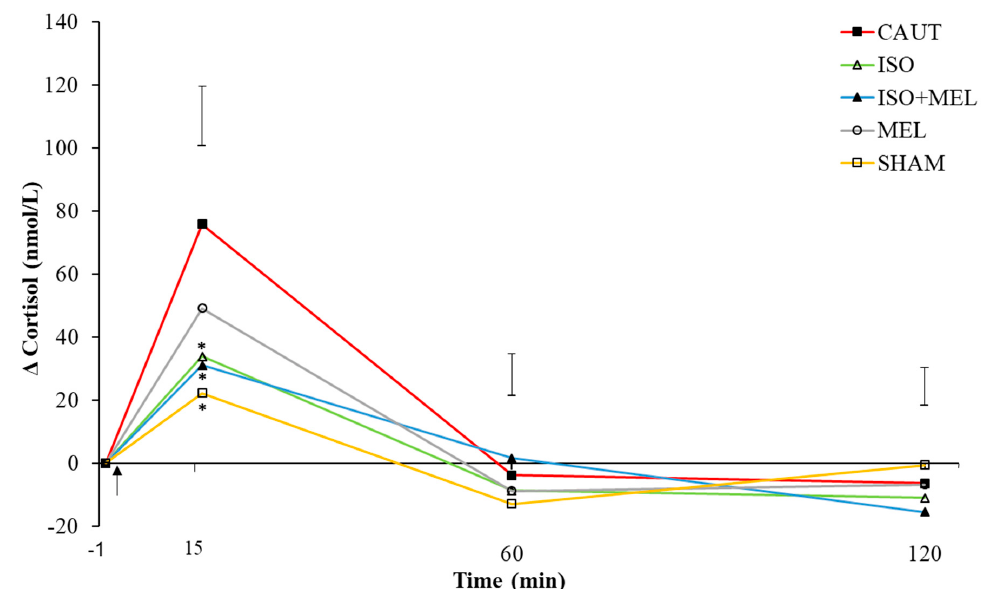
Figure 1. Mean change ( ± maximum standard error of the di ff erence) in plasma cortisol concentrations (from baseline; nmol / L) over 2 h post-treatment of goat kids (n = 10 / treatment) that were either (i) cautery-disbudded with no pain relief (CAUT) or disbudded following administration of (ii) isoflurane (ISO), (iii) meloxicam s.c. and isoflurane (ISO + MEL) or (iv) meloxicam s.c. alone (MEL). (v) Sham-handled kids (SHAM) acted as controls. Asterisks represent means that di ff er from CAUT kid means within each time point at p ≤ 0.05. Arrow indicates time of treatment. There was no treatment ‐ by ‐ time interaction for change in glucose concentrations ( F 8, 63 = 0.8, p =